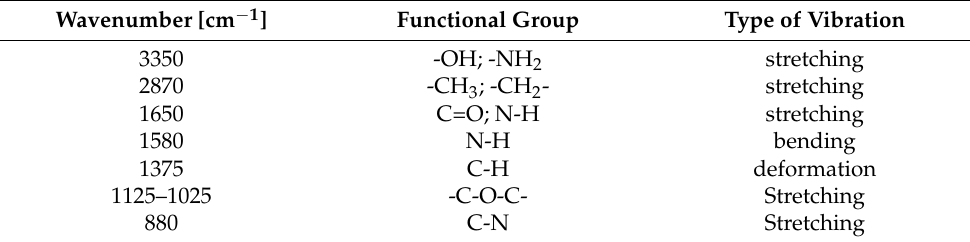
Table 5. Summary of observed vibrations.